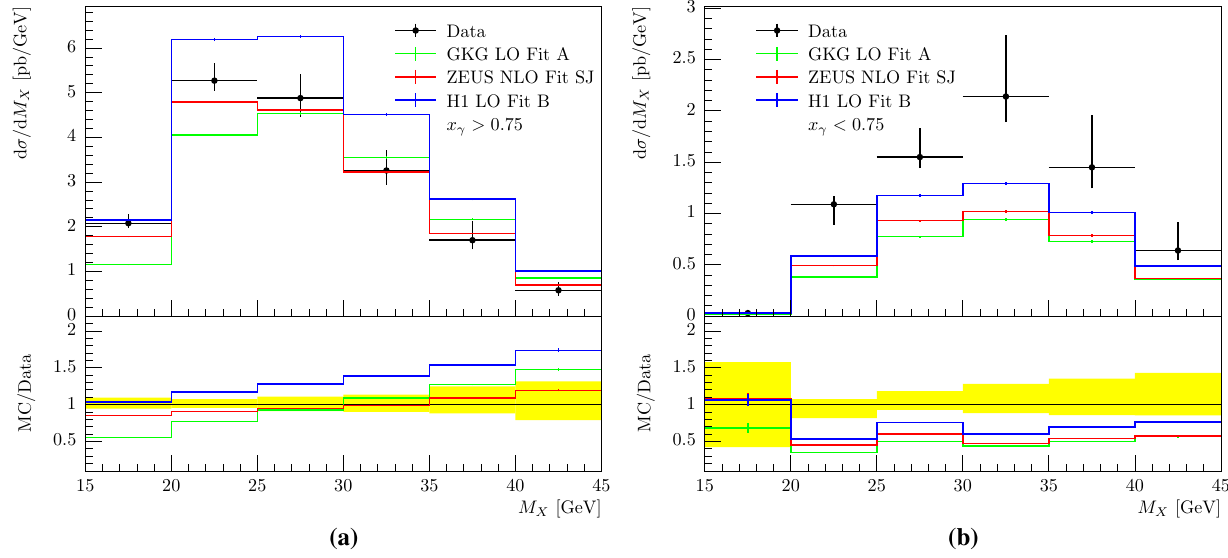
Fig. 12 The model with gap suppression using the three dPDFs: H1 Fit B LO (blue lines), GKG LO Fit A (green lines) and ZEUS SJ (red lines) compared to ZEUS data on M X in the direct-enhanced ( a ) and resolved-enhanced ( b )